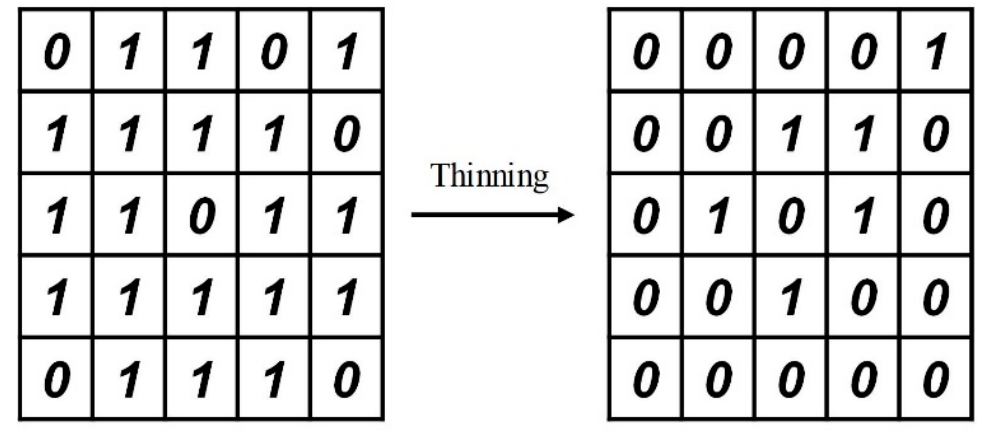
Figure 5. Thinning algorithm for binary region.